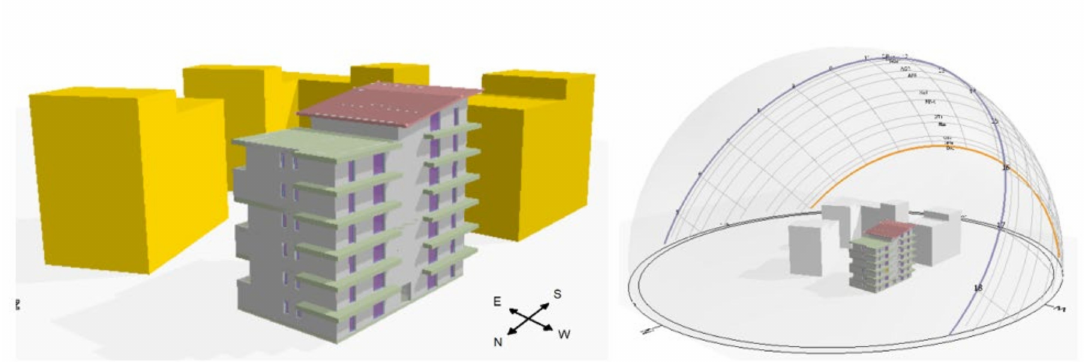
Figure 10. Case-study building and related sun paths for radiative loads